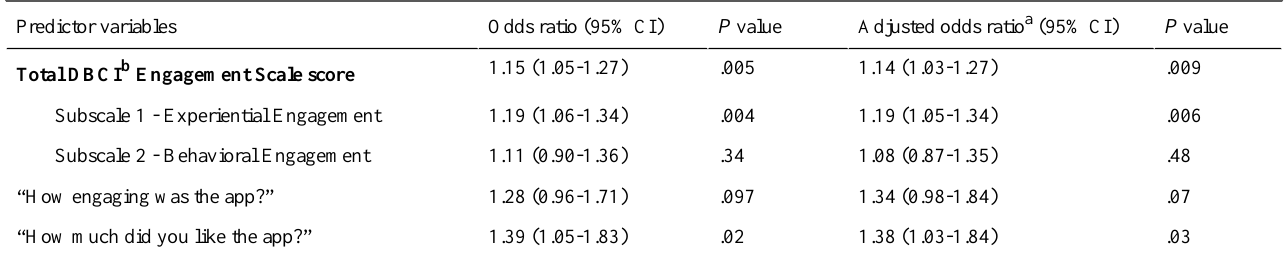
Table 5. Unadjusted and adjusted odds ratios for the associations between the predictor variables and future behavioral engagement.